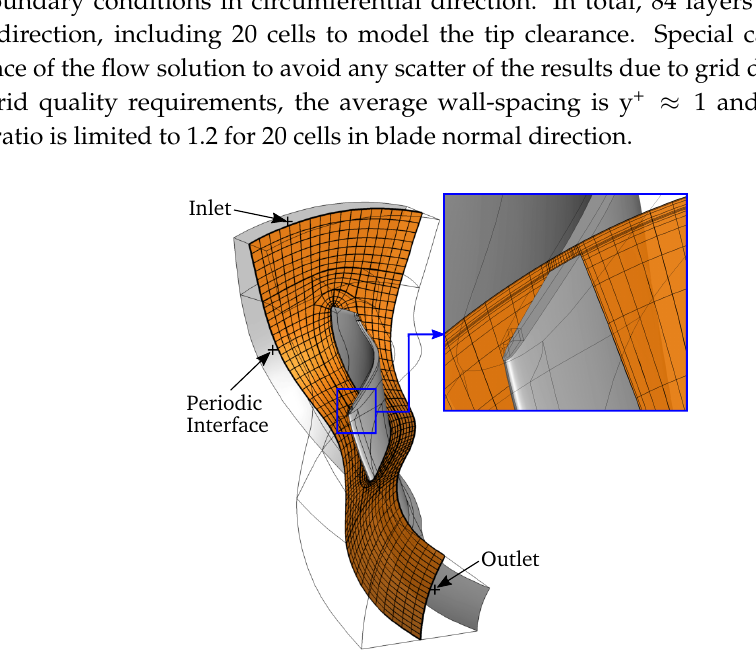
Figure 7. Computational domain of the turbine wheel with a close-up of the tip clearance mesh with an axial cross section through the 3D grid (every 4th grid line